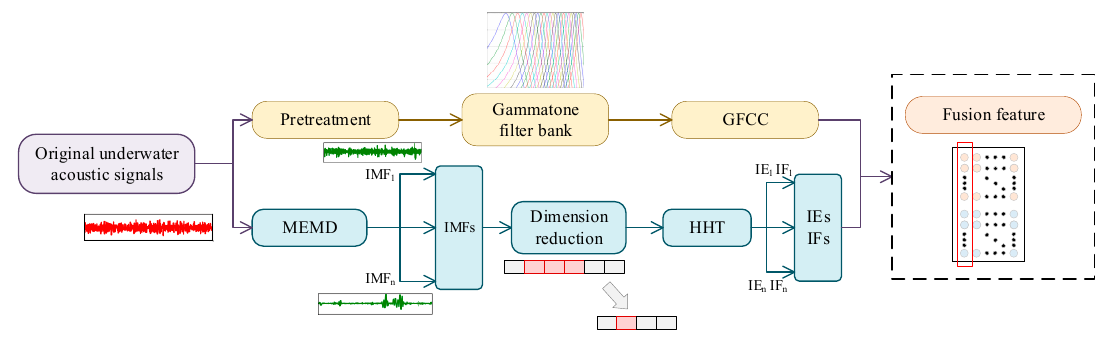
Figure 7. The process of feature extraction.